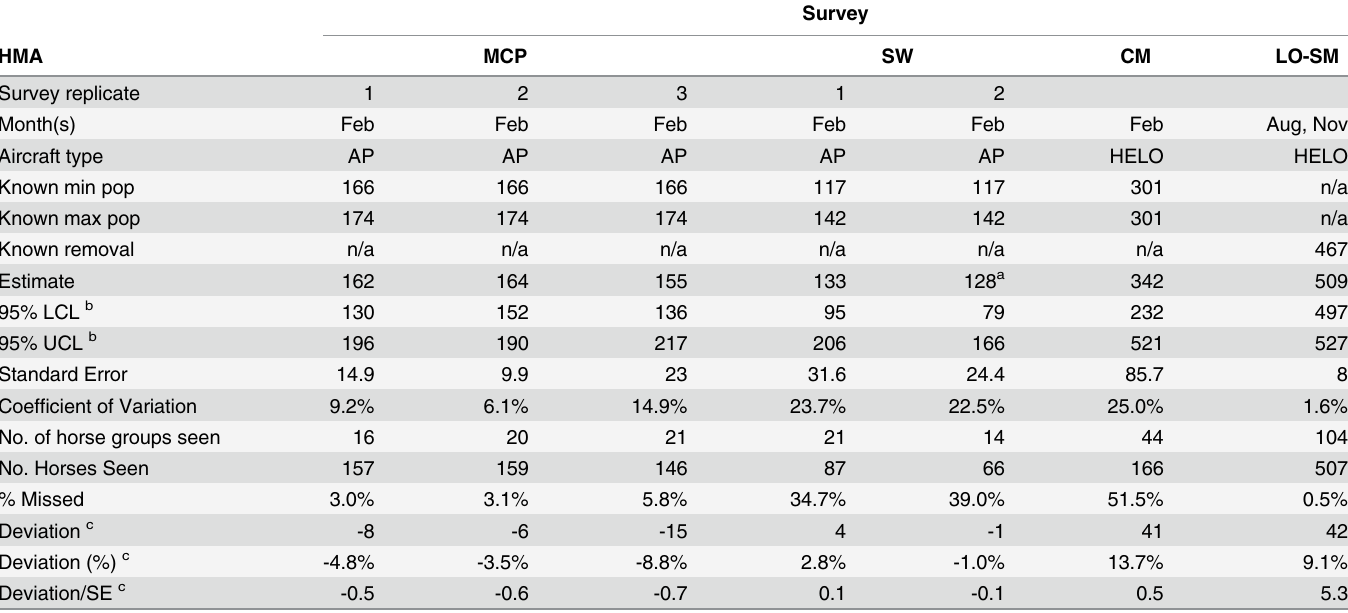
Table 2. Abundance or removal estimates from aerial surveys and known population or removal sizes of feral horses ( Equus caballus) in western USA. U.S. Bureau of Land Management Herd Management Area (HMA) surveys: McCullough HMA, Wyoming (MCP), 3 replicates; Sand Wash HMA, Colo- rado (SW), two replicates; Cedar Mountain HMA, Utah (CM); and change due to removal at Little Owyhee-Snowstorm Mountains HMAs, Nevada (LO-SM), USA. Aircraft types: airplane (AP) and helicopter